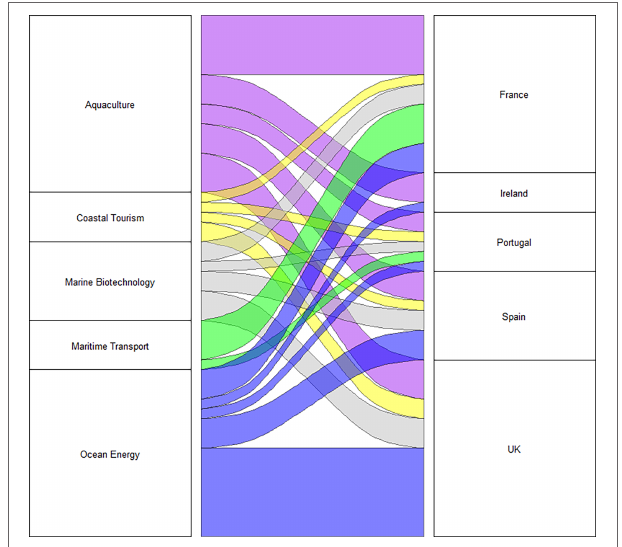
FIGURE 5 | Alluvial diagram presenting national level financier by Blue Economy sector identified in this study. Note: data is based on online